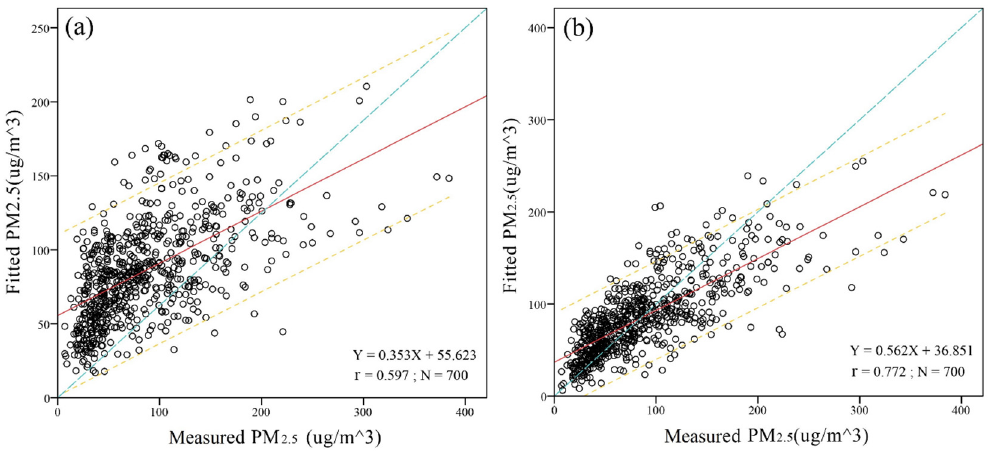
Figure 8. Cont. Figure 8.